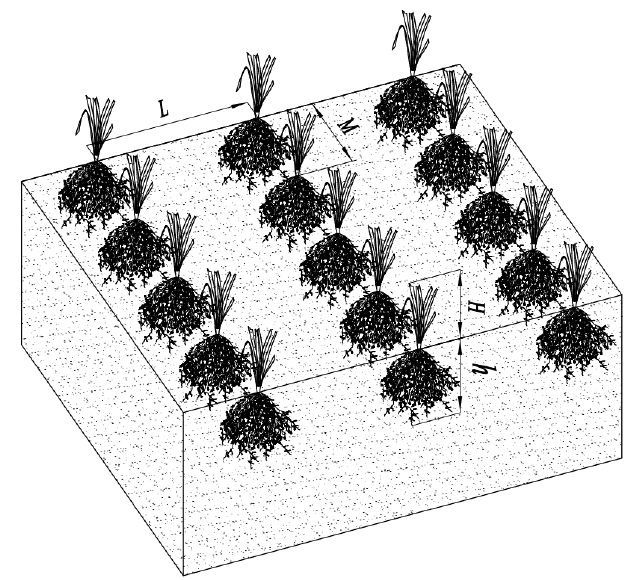
Figure 5. Planting pattern.